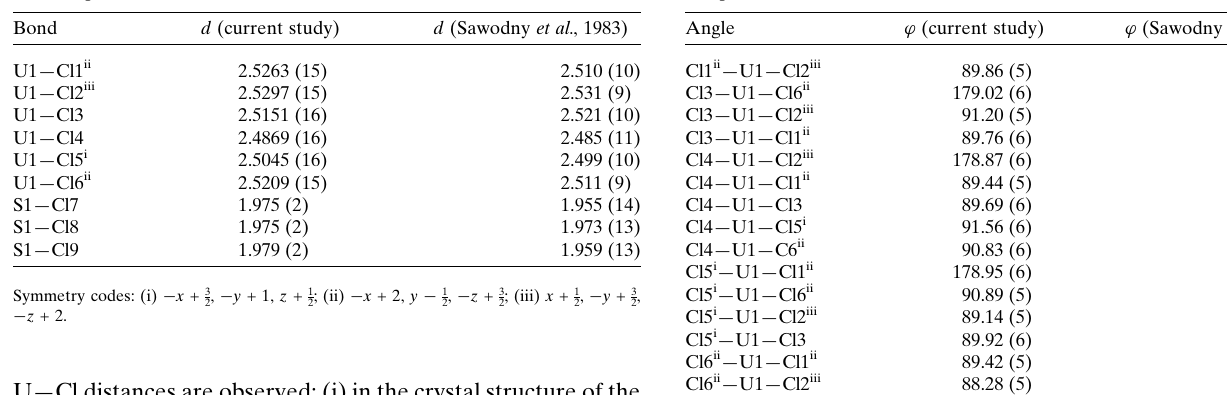
Table 2 Comparison of selected angles ’ ( (cid:4) ) for (SCl 3 )[UCl 6 ] from the current and the previous refinement.